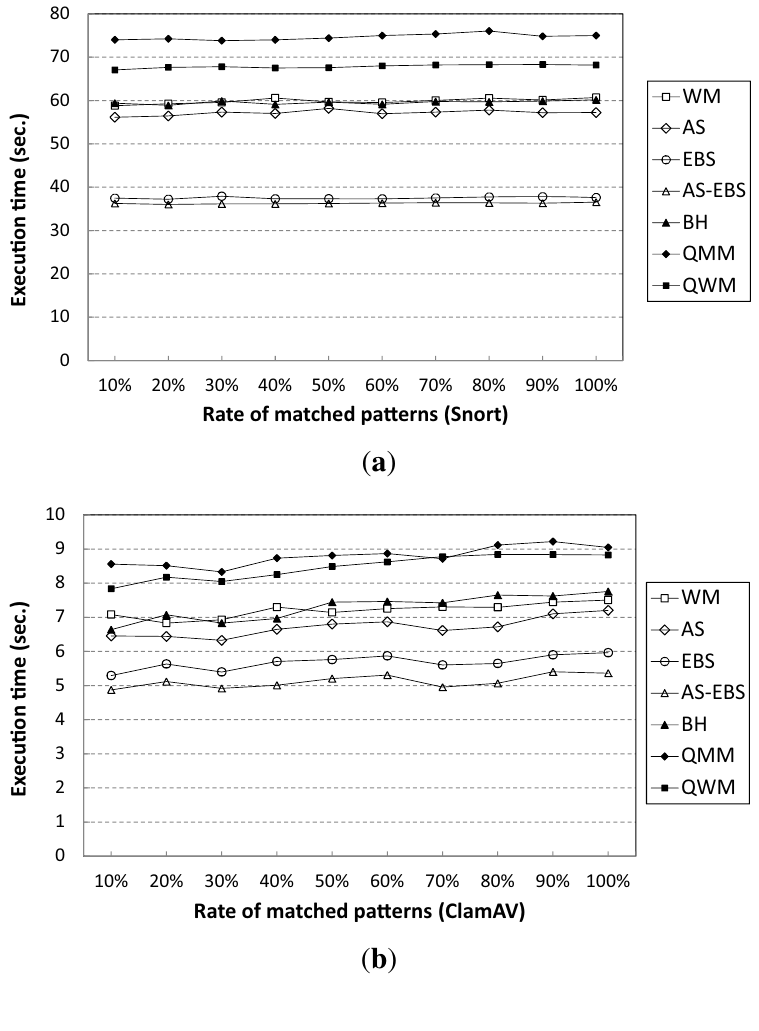
Figure 10. Performance results of different input data streams. ( a ) Snort; ( b )